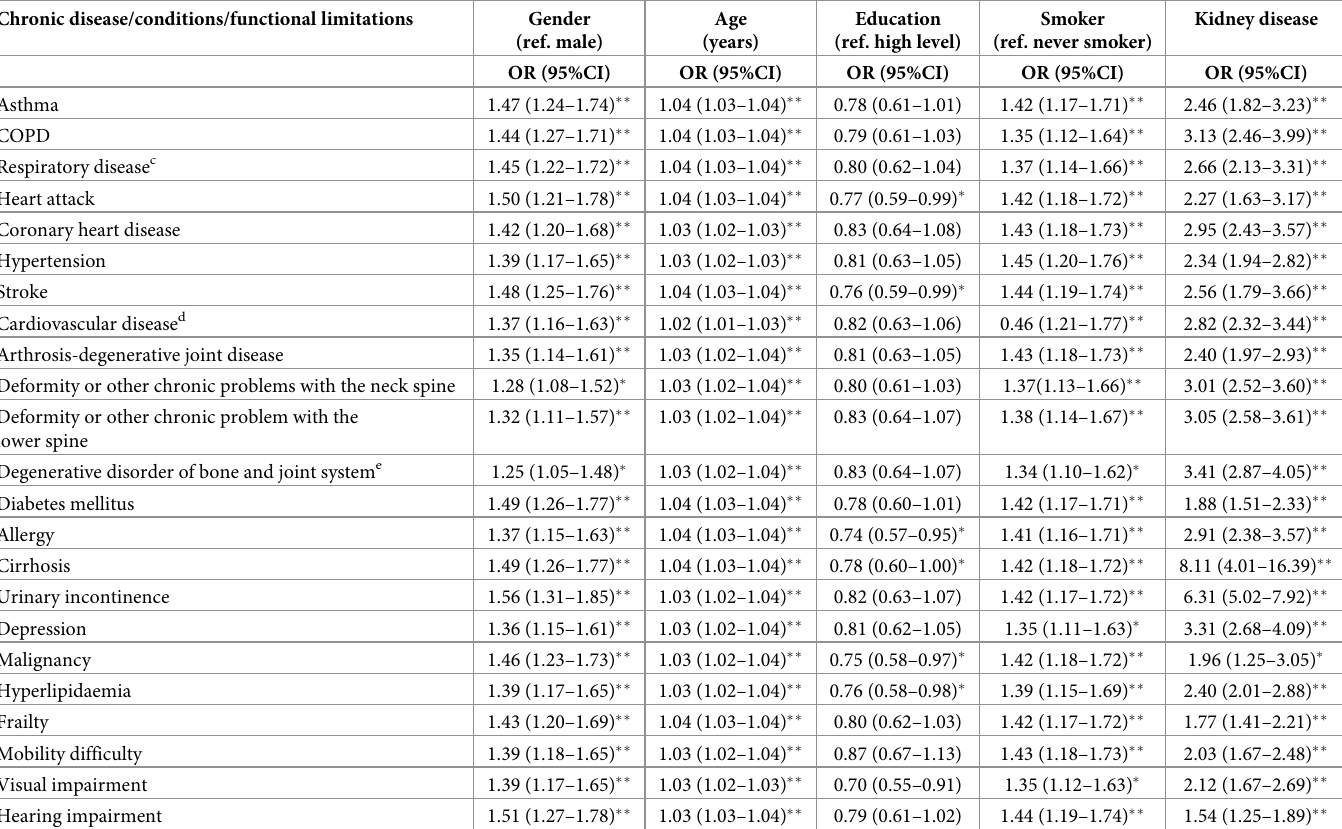
Table 4. Odds ratios for associations between chronic diseases, conditions and functional limitations in respondents who reported presence of kidney disease, adjusted for gender, age, education level and smoking status, Republic of Serbia, 2013. Chronic disease/conditions/functional